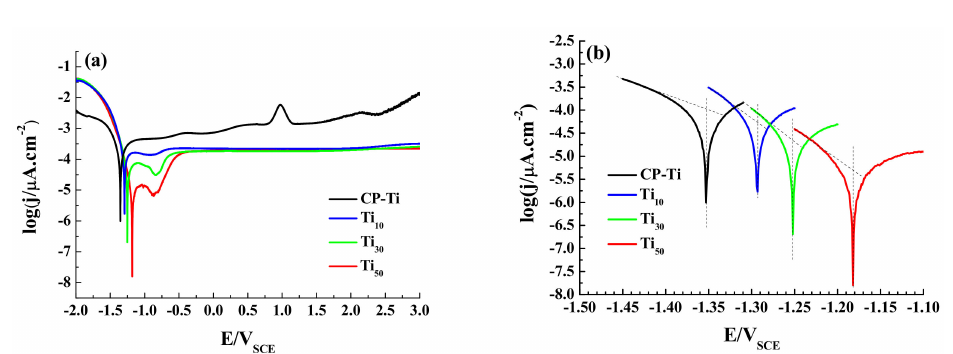
Figure 8. Potentiodynamic polarization curves of the CP-Ti, Ti 10 , Ti 30 and Ti 50 samples in 3.5 wt.% NaCl solution. ( a ) Potentiodynamic polarization curves for all samples; ( b ) Tafel extrapolation plot for all samples.